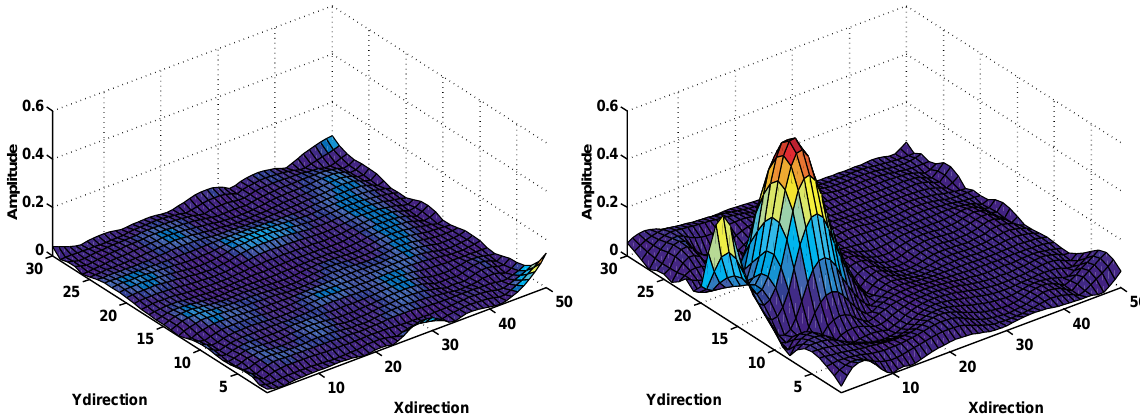
Fig. 12. Spatial view of the FRF nonlinear distortion extracted with the proposed spatial residual technique, for undamaged (left) and damaged (right) states of the device under